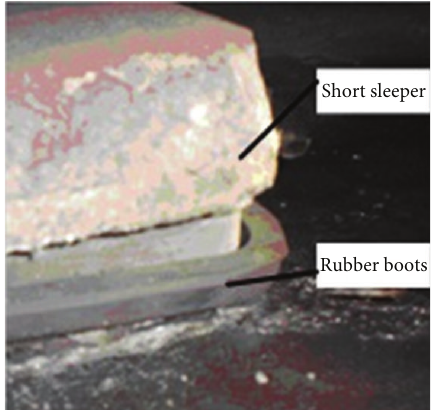
Figure 1: Voided elastic two-block